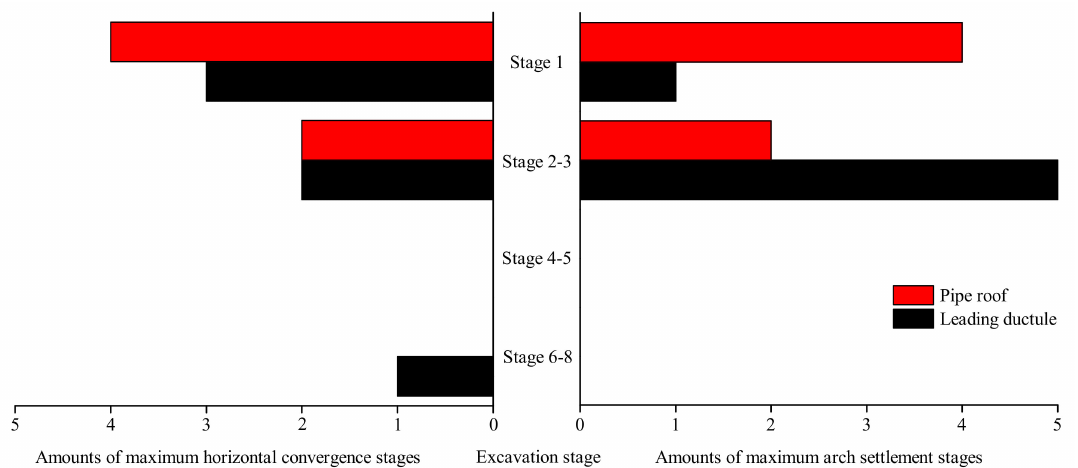
Figure 15. Distribution of maximum arch settlement and horizontal convergence stage in all monitoring